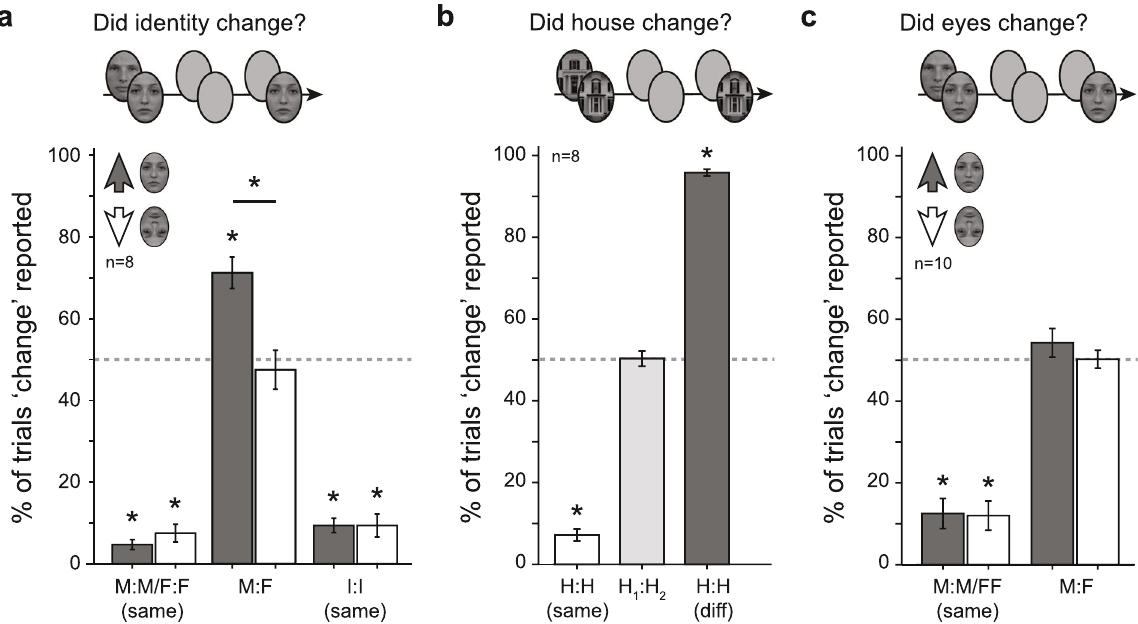
Figure 2. Interocular merging of face images depends on attention to holistic face properties. ( a ) Results from Experiment 3A. Percentage of trials in which observers reported an identity change between pre- and post- blank presentation intervals. M:M, F:F and I:I denote male, female and intermediate morph face images in both eyes respectively. For M:F there was a male face in one eye and a female face in the other eye. Gray bars depict results for upright faces, white bars upside-down faces ( * p < 0.01, compared to of the level expected for rivalling stimuli of 50%). ( b ) Results from control Experiment 3C. Percentage of trials in which observers reported a change in perceived house between pre- and post-blank presentation intervals. For H:H conditions, the same house images were presented to both eyes and probed with either that same (‘same’, white) or a different (‘diff’, dark gray) image in the post-blank interval. For H 1 :H 2 , there were different house images presented to the individual eyes in the pre-blank interval and only one of the two images was presented again after the blank. ( * p < 0.001, compared to a chance level of 50%). ( c ) In Experiment 4, observers reported eye changes for M:M and F:F face images ( * p < 0.001, compared to a chance level of 50%). For M:F, they report eye changes on 50% of trials supporting the notion that interocular merging does not occur when features instead of holistic faces are attended. Error bars are ±